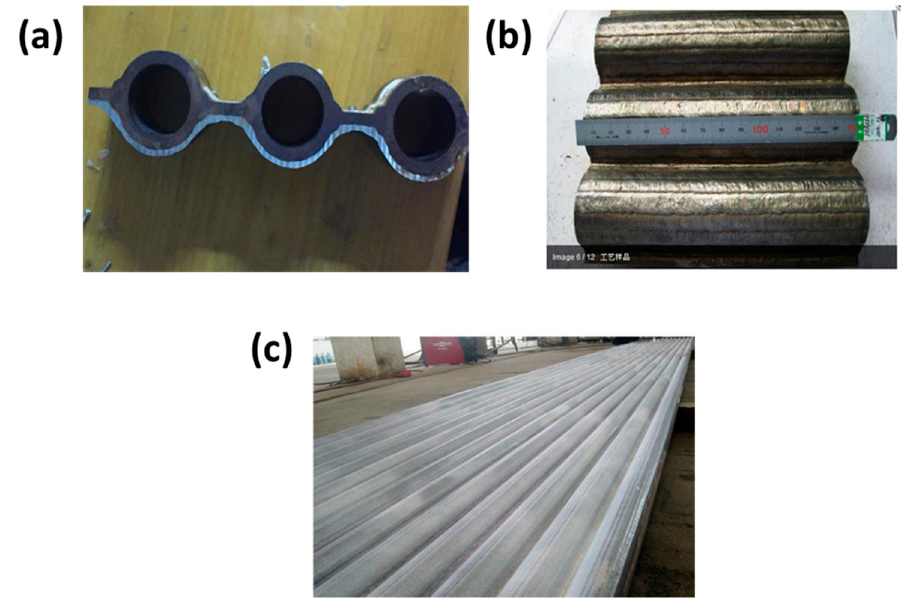
Figure 10. ( a ) The tube walls section; ( b ) weld overlay result on the tube panels; ( c ) the entire tube wall’s surface.